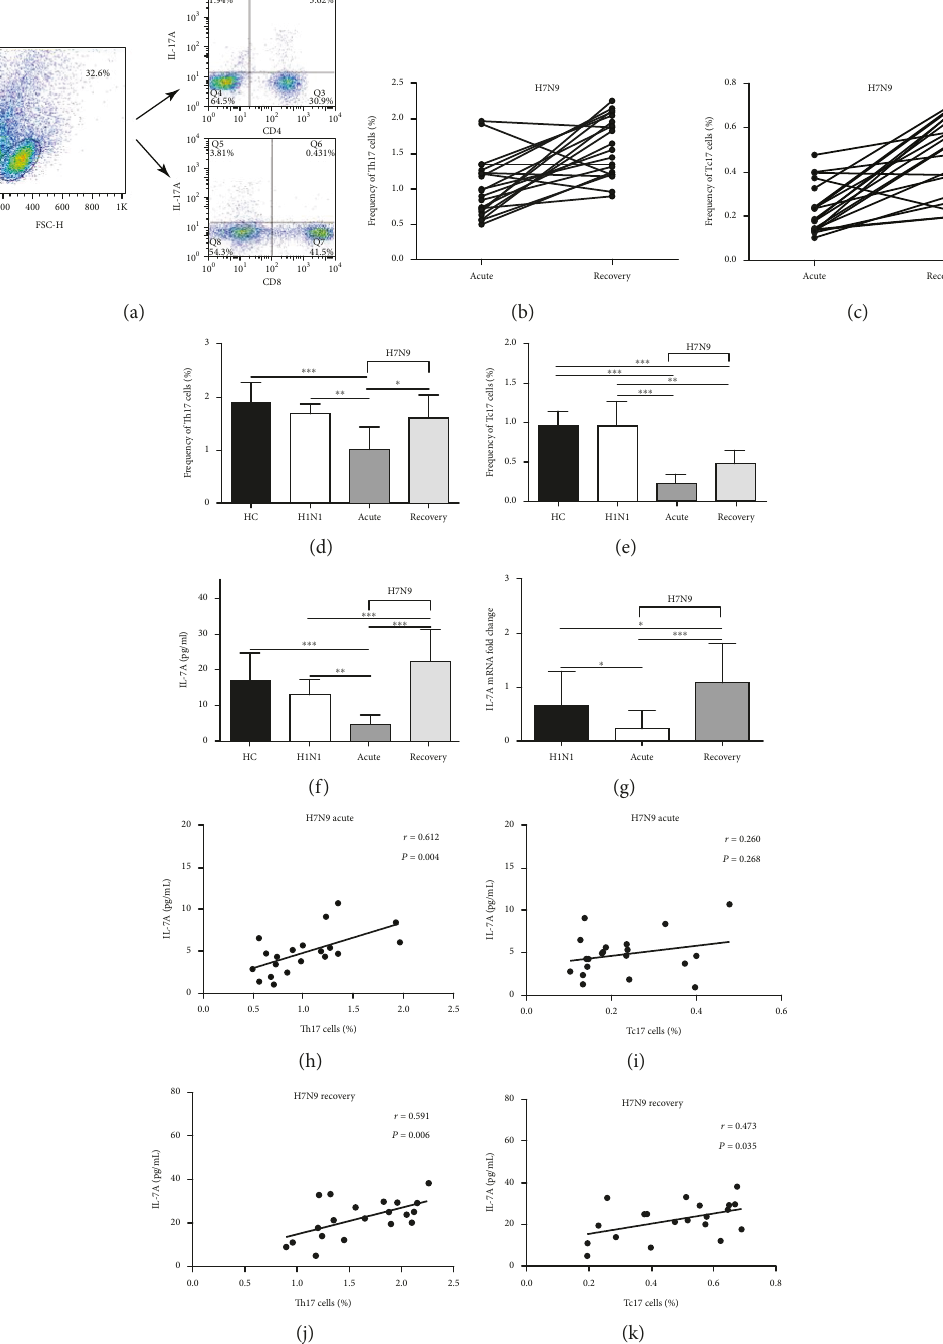
Figure 1: Changes in Th17 cells, Tc17 cells, and IL-17A levels among PBMCs from H7N9 patients in the acute and recovery phases. (a) Isolated PBMCs were gated initially for lymphocytes, and CD4 + IL-17A + (Th17) and CD8 + IL-17A + (Tc17) cells were then analyzed. (b, c) The di ff erent frequencies of Th17 (b) and Tc17 (c) cells in the acute and recovery phases in di ff erent H7N9 patients ( n = 20 ). (d, e) Comparison of the proportions of Th17 (d) and Tc17 (e) cells obtained from HC and H1N1(2009) and H7N9 patients in the acute and recovery phases ( n = 20 , respectively). (f) Serum levels of IL-17A in HC and H1N1(2009) and H7N9 patients ( n = 20 , respectively). (g) The fold change in IL-17A mRNA levels in H1N1(2009) and H7N9 patients compared with HC ( n = 20 , respectively). (h, i) Correlation analysis of serum IL-17A levels and Th17 cells (h) and Tc17 cells (i) in H7N9 acute-phase patients. (j, k) Correlation analysis of serum IL-17A levels and Th17 cells (j) and Tc17 cells (k) in H7N9 recovery-phase patients. ∗ P < 0 05 , ∗∗ P < 0 01 , and ∗∗∗ P < 0 001 . HC: healthy